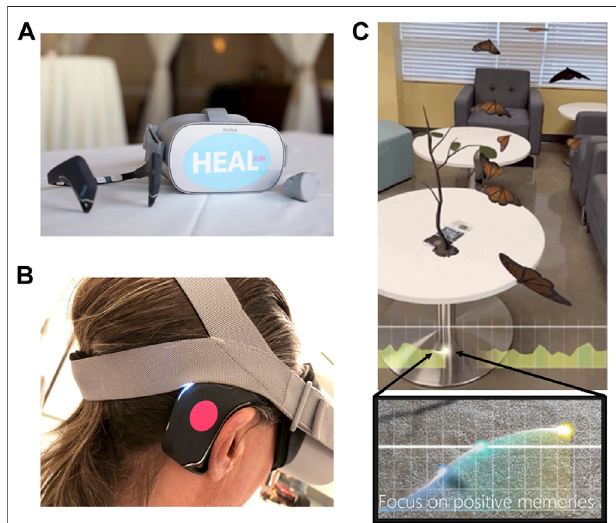
FIGURE 1 | Example of the equipment and AR visual experience. (A) Muse headband for neurofeedback and the Healium augmented reality headset. (B) The Healium neurofeedback setup as worn. (C) A screenshot of theAR-guidedmeditationwithchrysalishatchingneurofeedback.Below is an enlarged image of the threshold line (solid) and “ fi re fl y ” depicting gamma asymmetry ratios, with part of the meditation instruction shown in